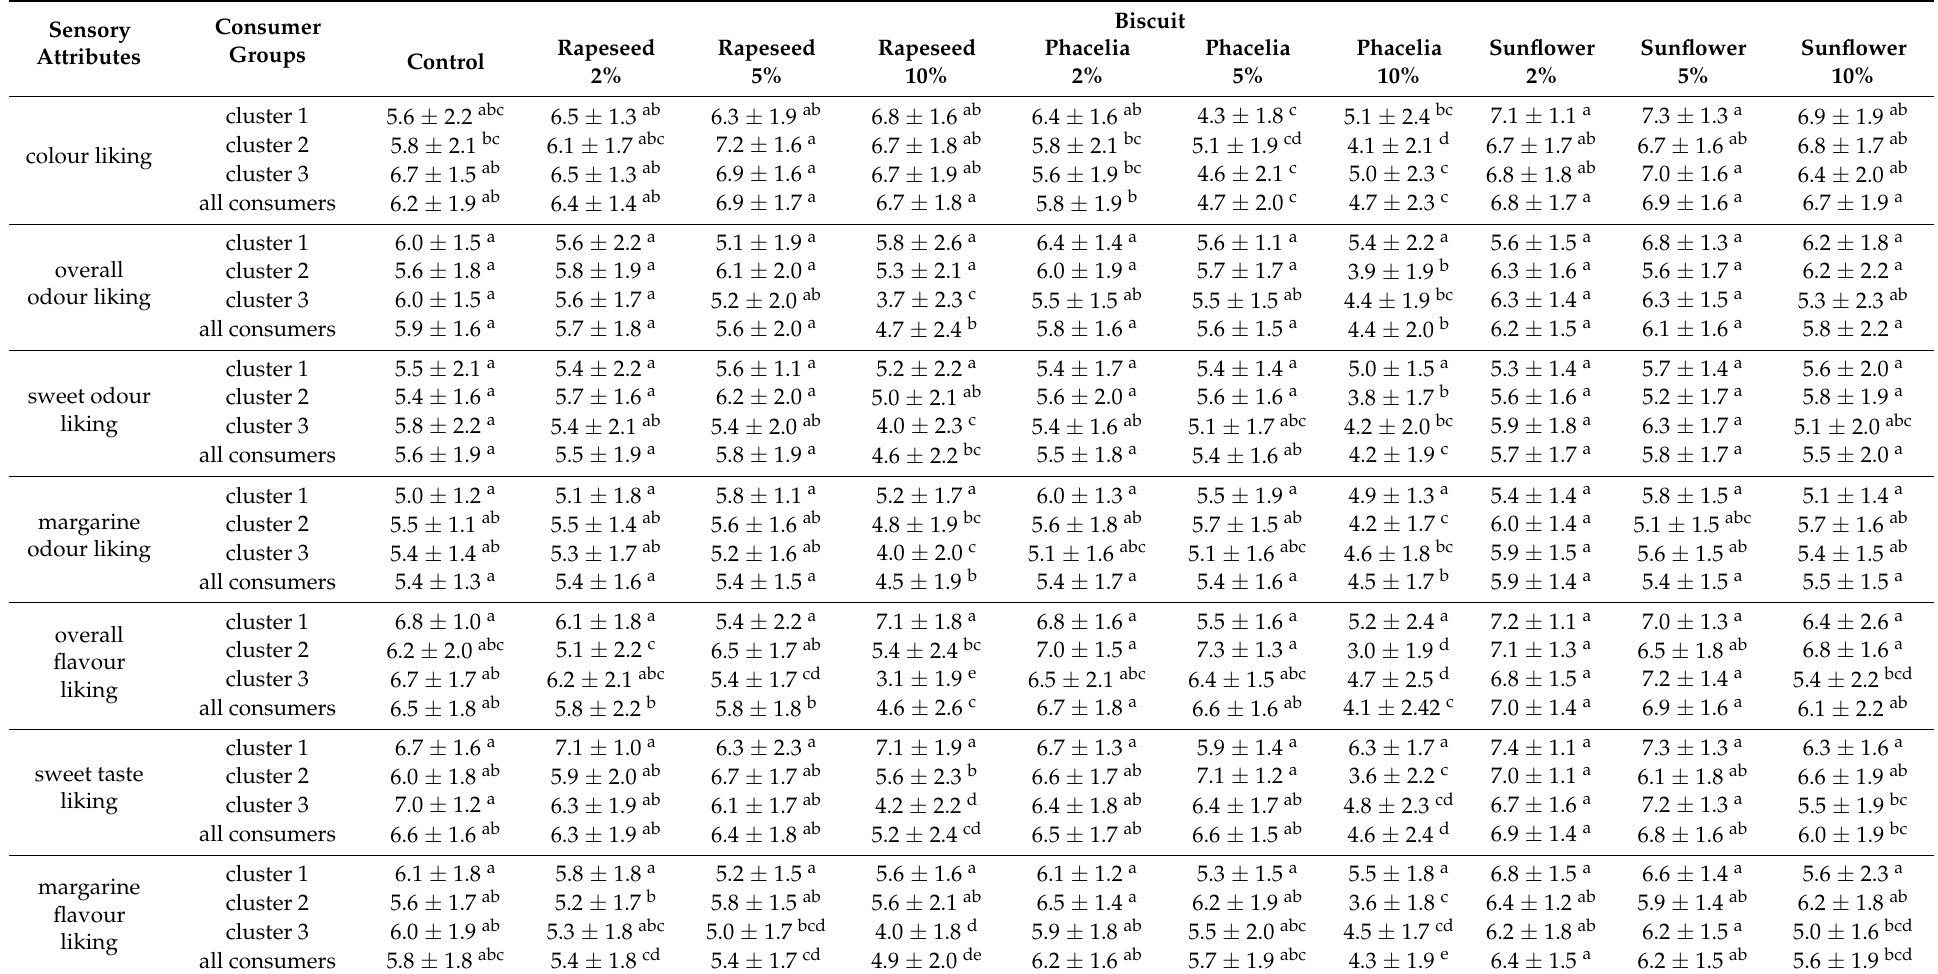
Table 10. Consumer liking scores of